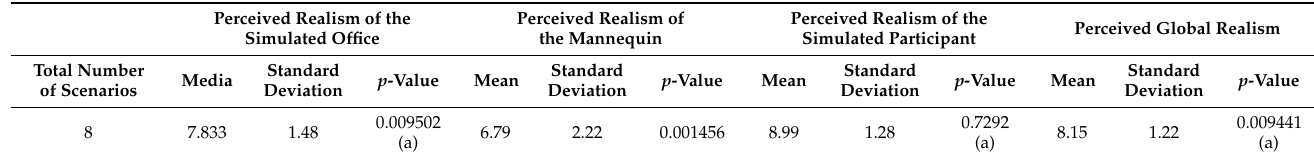
Table 2. Realism perceived by students in global terms.